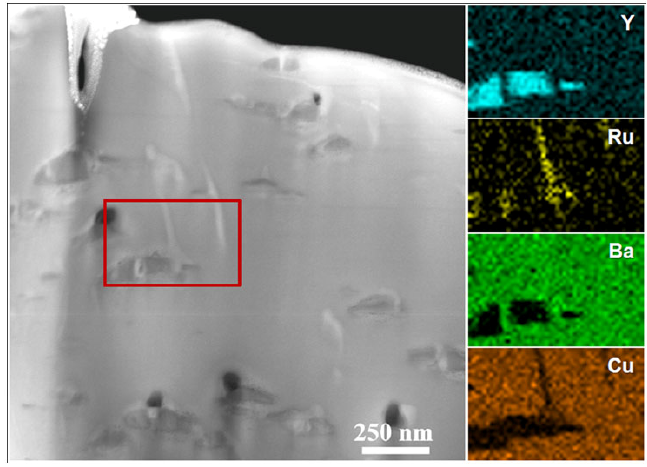
O and the BRYO 2 3